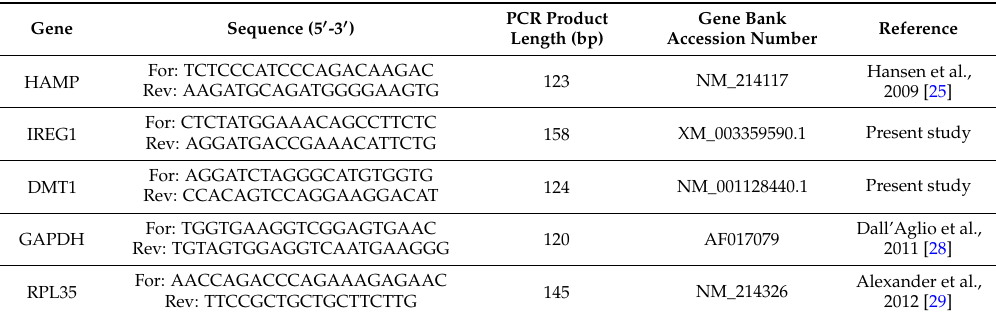
Table 2. Primer sequences used for quantitative real-time polymerase chain reaction